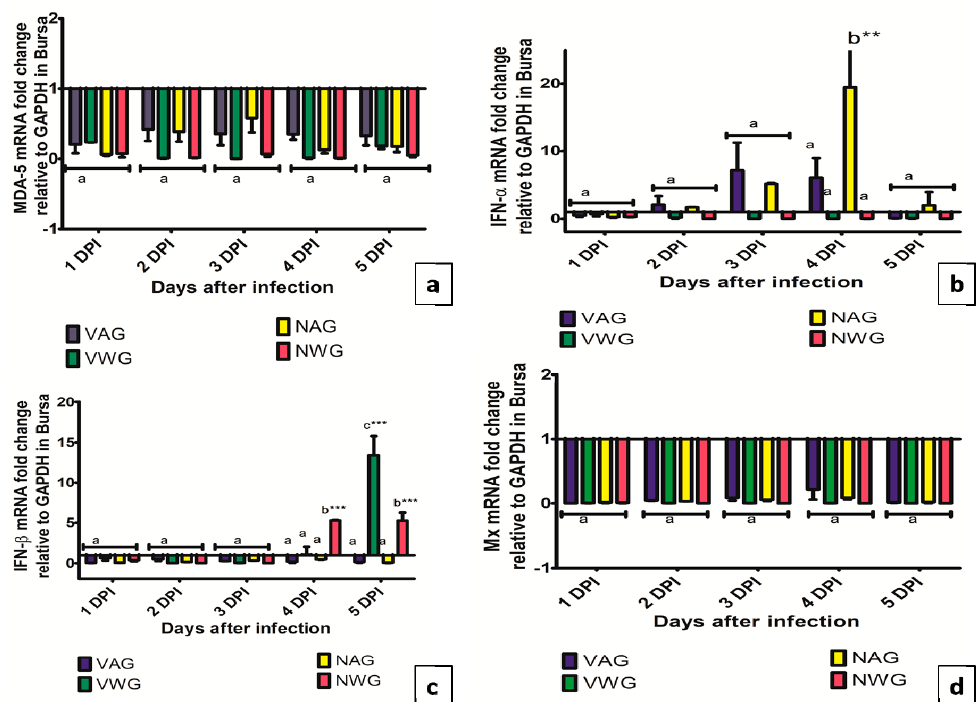
Figure 5. Expression of ( a ) MDA-5 ( b ) IFN- α ( c ) IFN- β ( d ) Mx. genes in Bursa of vaccinated and Non-vaccinated Aseel and White Leghorn chicken infected with very virulent IBDV. The groups were as follows: VAG-Vaccinated Aseel Group; VWG-Vaccinated White Leghorne group; NAG-Non-vaccinated Aseel Group; NWG- Non-vaccinated White Leghorn Group. Error bars represent standard error of the mean. Relative changes in the expression of genes were quantified by real-time PCR by comparison with expression levels of the housekeeping gene GAPDH and expressed as the fold-change. The value of 1.00 was kept as the control and the fold change values which were above the control values were considered as significant. *significant difference comparing VAG with VWG and NAG with NWG chickens of the same line at the same point where p < 0.01 **, p < 0.001 ***. ( a – c ): Experimental groups sharing common lowercase superscript letters are statistically non-significant for each observation